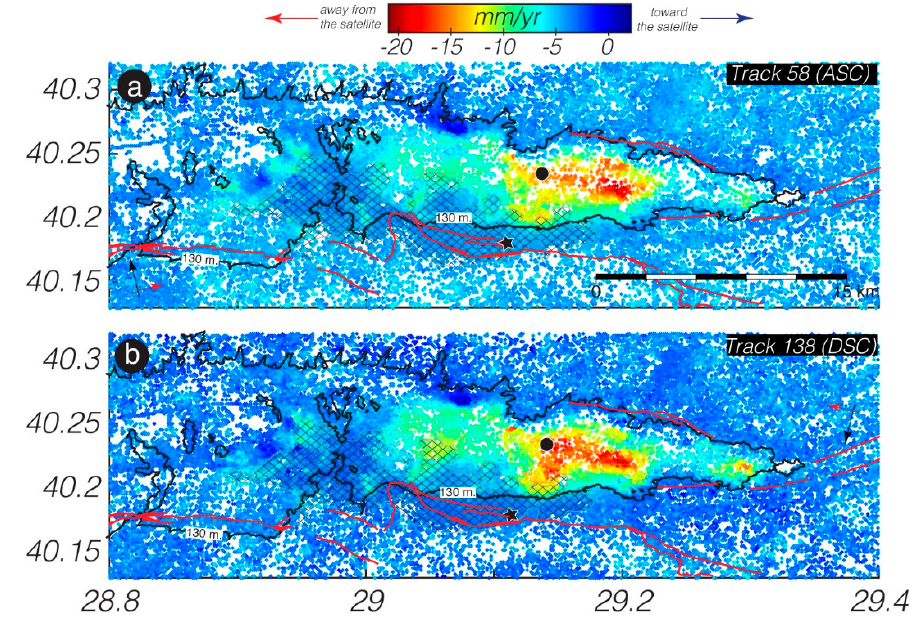
Figure 4. Line-of-sight (LOS) velocity maps from Sentinel 1A/B time-series analysis for the time period of 2014-2017. Positive velocities (cold colors) represent stable areas and displacement of the ground toward the satellite while negative velocities (warm colors) indicate displacement away from the satellite. Average line-of-sight velocity ( a ) on ascending track 58; and ( b ) on descending track 138. Elevation contours at 130 m around the subsiding Bursa Plain are shown in black solid lines. Shaded area shows the city extension of Bursa. Major active faults are drawn in red [57]. Black circles show the chosen location to illustrate the temporal evolution of the subsidence in Figure 8 referenced to a stable area (black solid star), considered as a stable area.